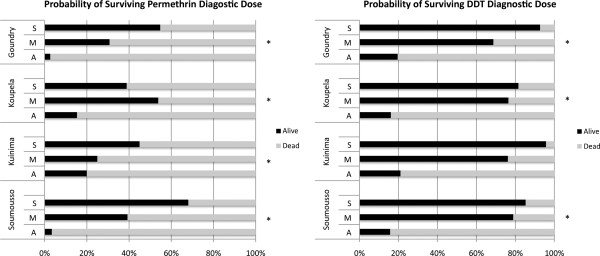
The percentage survival of Anopheles gambiae s.l. species/form 24 hours following exposure to DDT or permethrin. Data for 2010 and are stratified by species for each sentinel site. Statistical comparison between molecular forms and localities were performed using Z-test with significant differences (P < 0.05) showed in the figure (*).